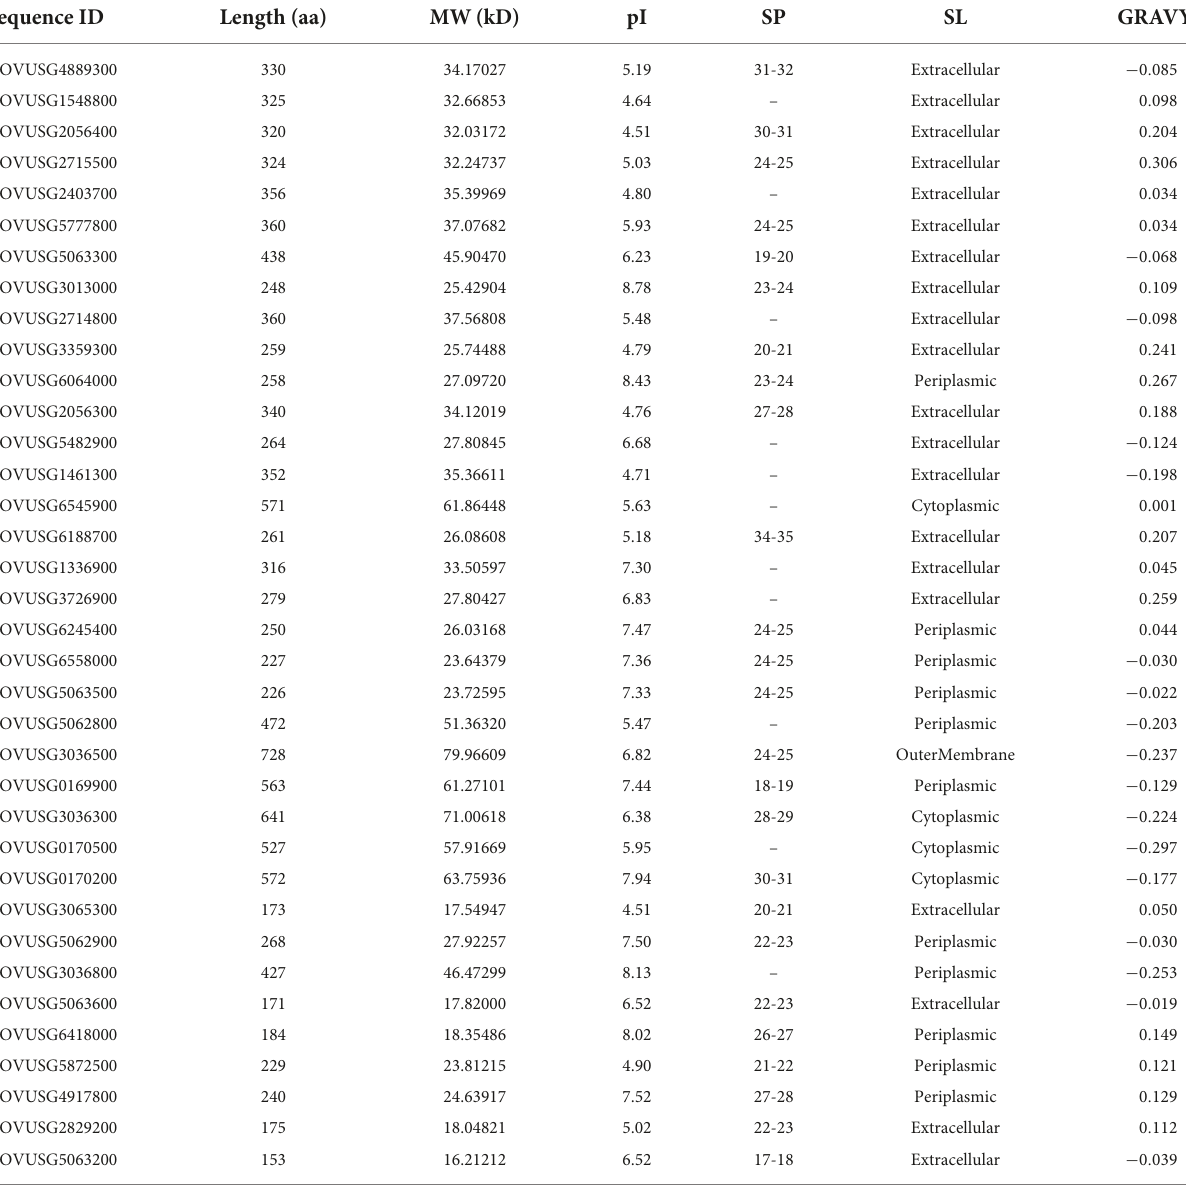
TABLE 1 Physical and biochemical properties of the TLPs identified in